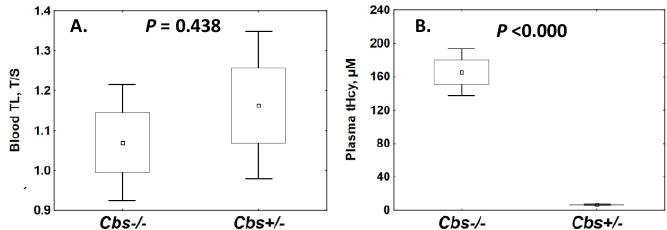
Figure 2. Blood telomere length (TL) ( A ) and plasma total Hcy (tHcy) levels ( B ) in Cbs − / − and Cbs +/ − mice. Blood TL and plasma tHcy were quantified in Cbs − / − mice ( n = 40) and sex- and age-matched control Cbs +/ − siblings ( n = 40) as described in the Materials and Methods. Box and whiskers represent the mean ± SEM and the mean ± 95% CI, respectively. Upper and lower p -values refer to data normalized to β -actin (blank boxes) and Gapdh (gray boxes) mRNAs, respectively.